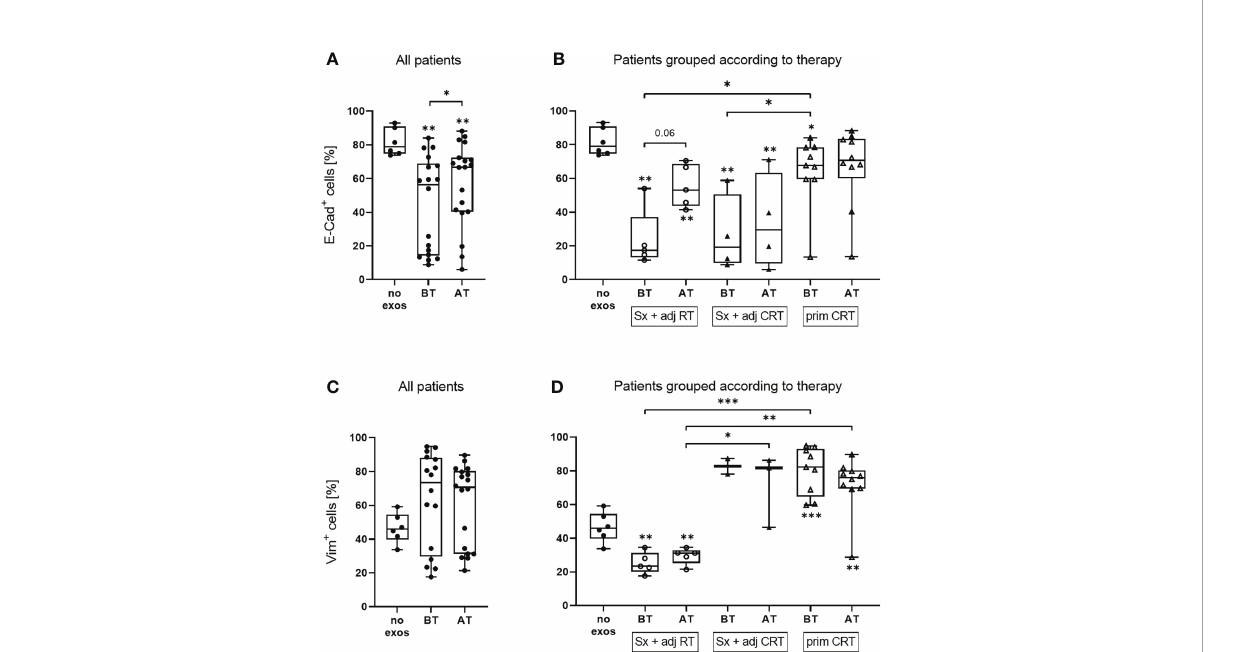
FIGURE 2 E-cadherin and vimentin protein expression of UD-1 cells upon co-incubation with exosomes isolated from plasma of HNSCC patients before and after therapy. UD-1 cells were co-incubated for 72 h with exosomes isolated from plasma of n = 19 HNSCC patients BT and AT. Following, E-cadherin (A, B) and vimentin (C, D) expression of co-incubated UD-1 cells was assessed by fl ow cytometry. As controls, UD-1 cells without exosome treatment (no exos, n = 6) were included. Results are shown ungrouped (A, C) or grouped according to therapy (B, D) . N = 5 HNSCC patients were treated with Sx + adj RT, n = 4 with Sx + adj CRT and n = 10 with prim CRT. Results are plotted as box-and-whisker blots representing the median value, the 25th and 75th quartiles and the range. Wilcoxon related samples tests were applied to compare BT and AT. Mann-Whitney test was applied to compare no exos with each BT or AT. *, ** and *** correspond to p ≤ 0.05, p ≤ 0.01 and p ≤ 0.001, respectively. Asterisks above boxes indicate the signi fi cance compared to no